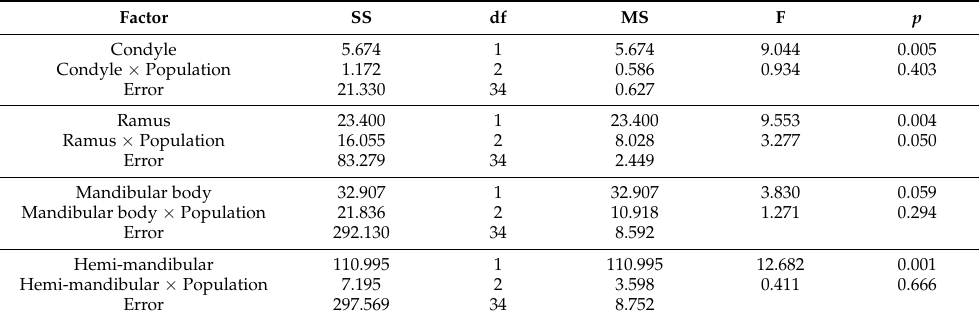
Table 7. Repeated-measures analysis of variance for adjustment of population for volume measure-